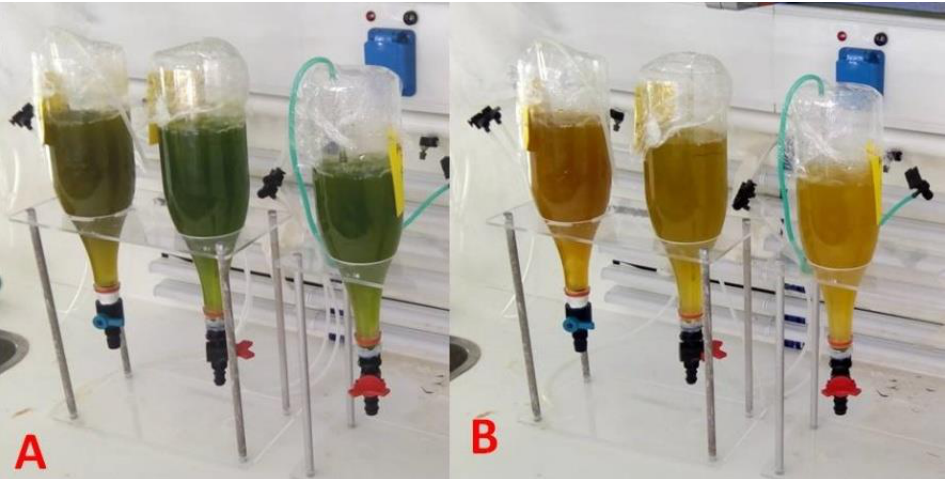
Figure 3. Coloration of Phormidium sp. mass at an early stage (5th day) ( A ) and at a late stage (15th day) ( B ) of its culture.